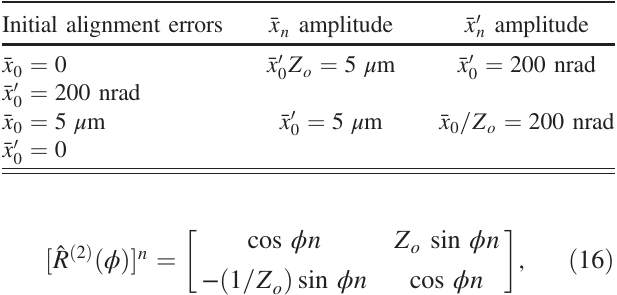
TABLE II. Initial x-ray beam (source) alignment errors and subsequent spatial and angular beam betatron oscillation ampli- tudes calculated with Eq.